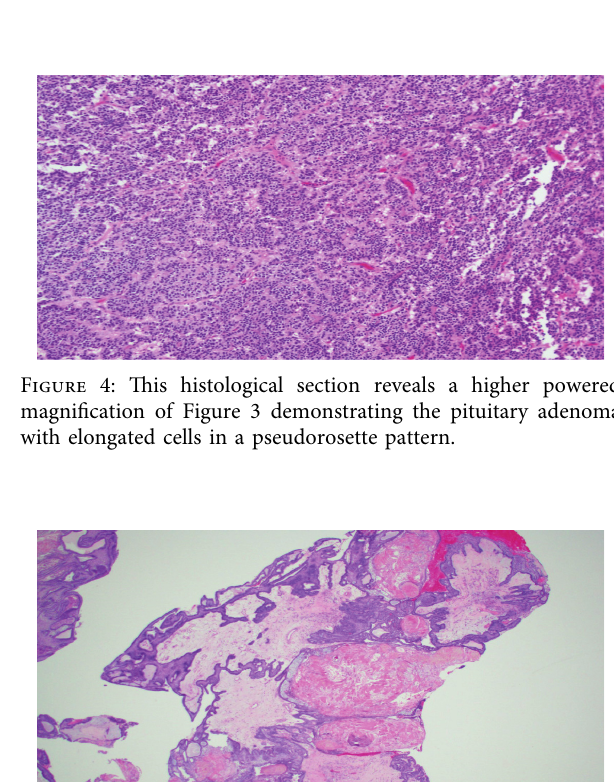
Figure 3: Histological examination revealing collision tumor transition point. The center of the image reveals pituitary adenoma tissue with elongated cells in a pseudorosette pattern. The sur- rounding tissue reveals the adamantinomatous craniopharyngioma with whorls of keratin and stellate reticulum.